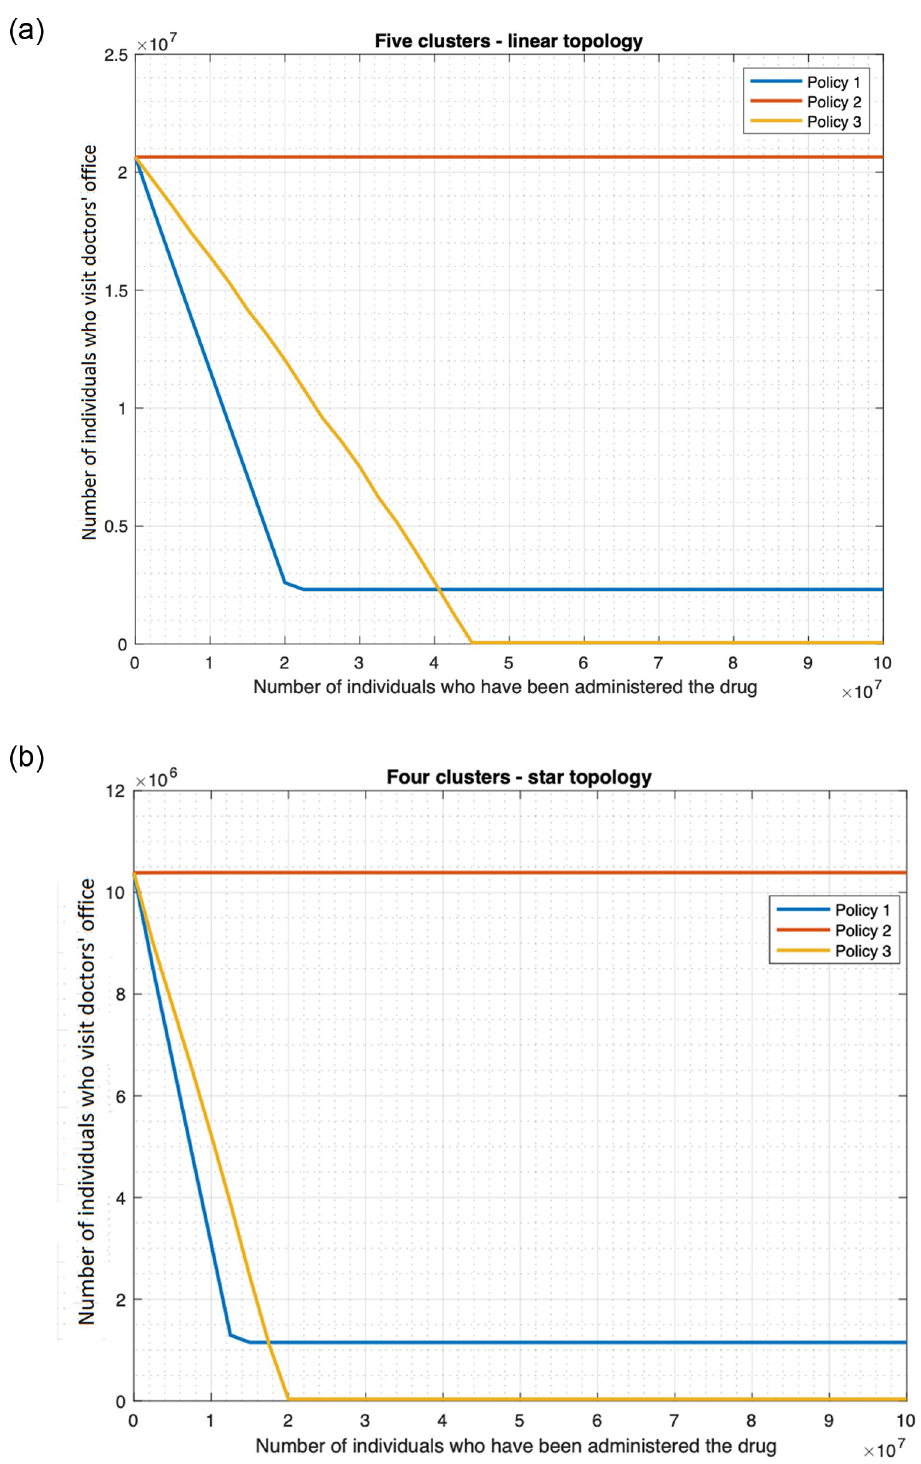
Fig 19. Health care load against drug availability. (a) Linear topology. (b) Star topology.